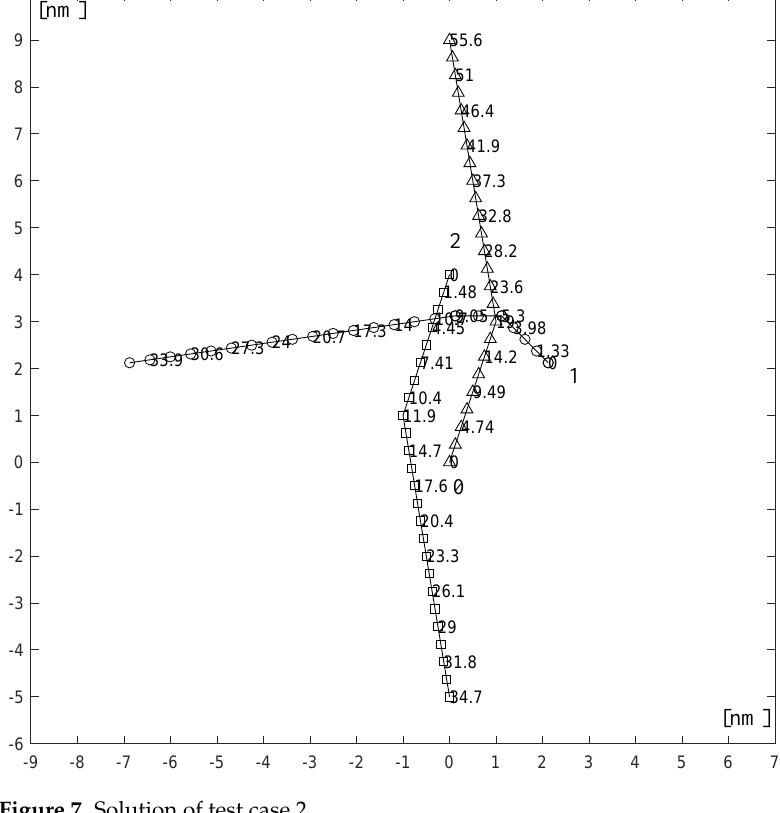
Figure 7. Solution of test case 2.